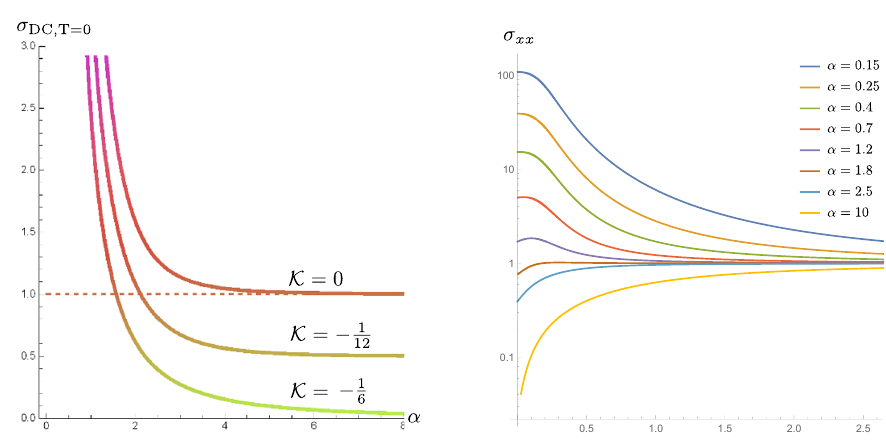
Figure 6 . Electric DC conductivity (cid:27) DC for the Linear model in zero magnetic (cid:12)eld. Left: (cid:27) DC at zero temperature as a function of the disorder strength (cid:11) for di(cid:11)erent K . Right: the temperature dependence of conductivity at di(cid:11)erent (cid:11) . A metal-insulator transition driven by the disorder is manifest. We worked in the canonical ensemble with (cid:26) = 1.